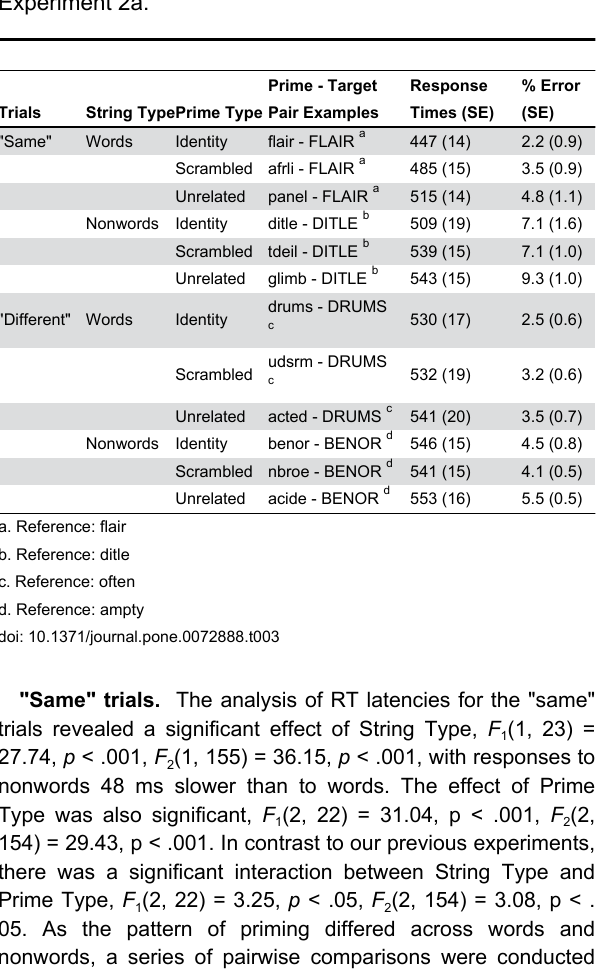
Table 3. Mean response times in milliseconds, percentage error rate, and standard error (SE) of the means of Experiment